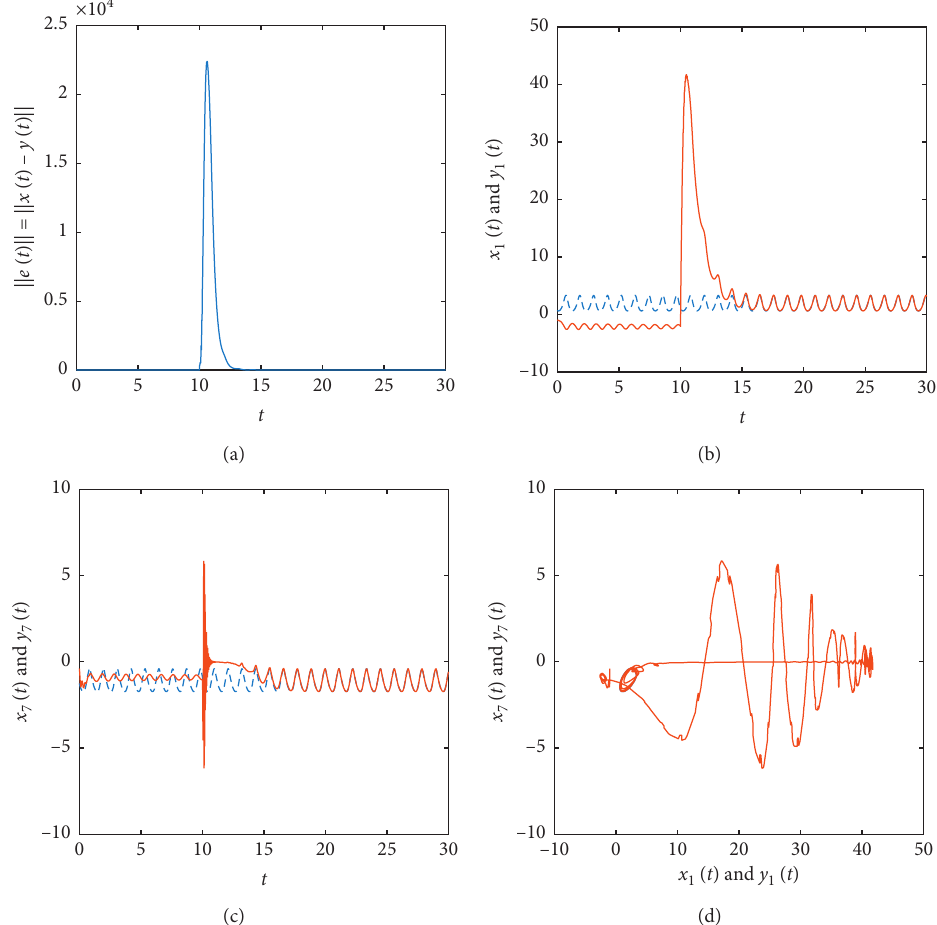
� 20 in the slave system (8) e norm of the error e versus time. 2 ( t ) and y ( t ) versus x ( t ) and y ( t ) 7 7 1 1